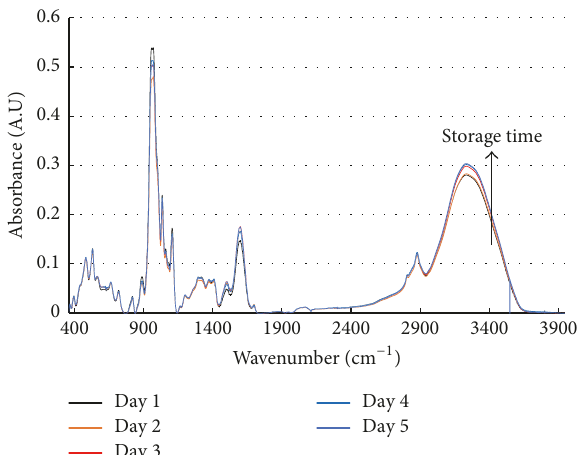
Figure 5: Mean spectra of the normalized bread spectra over 5 days of storage in room conditions.